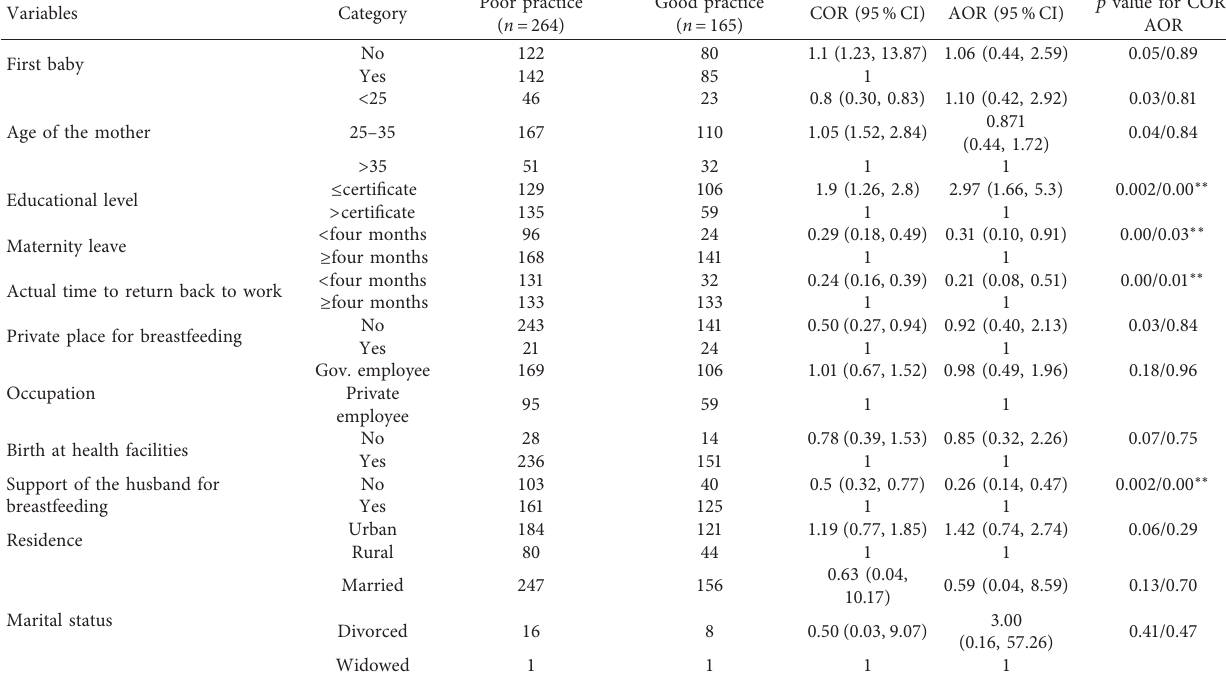
Table 6: The univariate and multivariate logistic regression analysis for practice of employed mothers in Mecha district, Northwest Ethiopia, 2019 ( n �